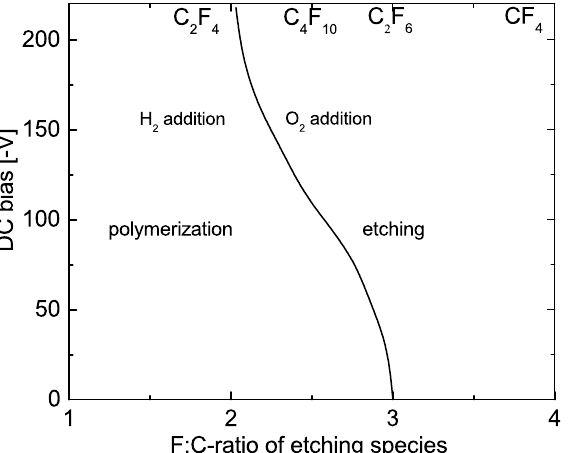
Figure 2. Schematic diagram of the influence of the ratio between F and C in the reactive gas and the DC bias voltage on the reaction behavior on the substrate. Enlarged loading as well as addition of hydrogen favors the formation of a polymeric film [17] (©